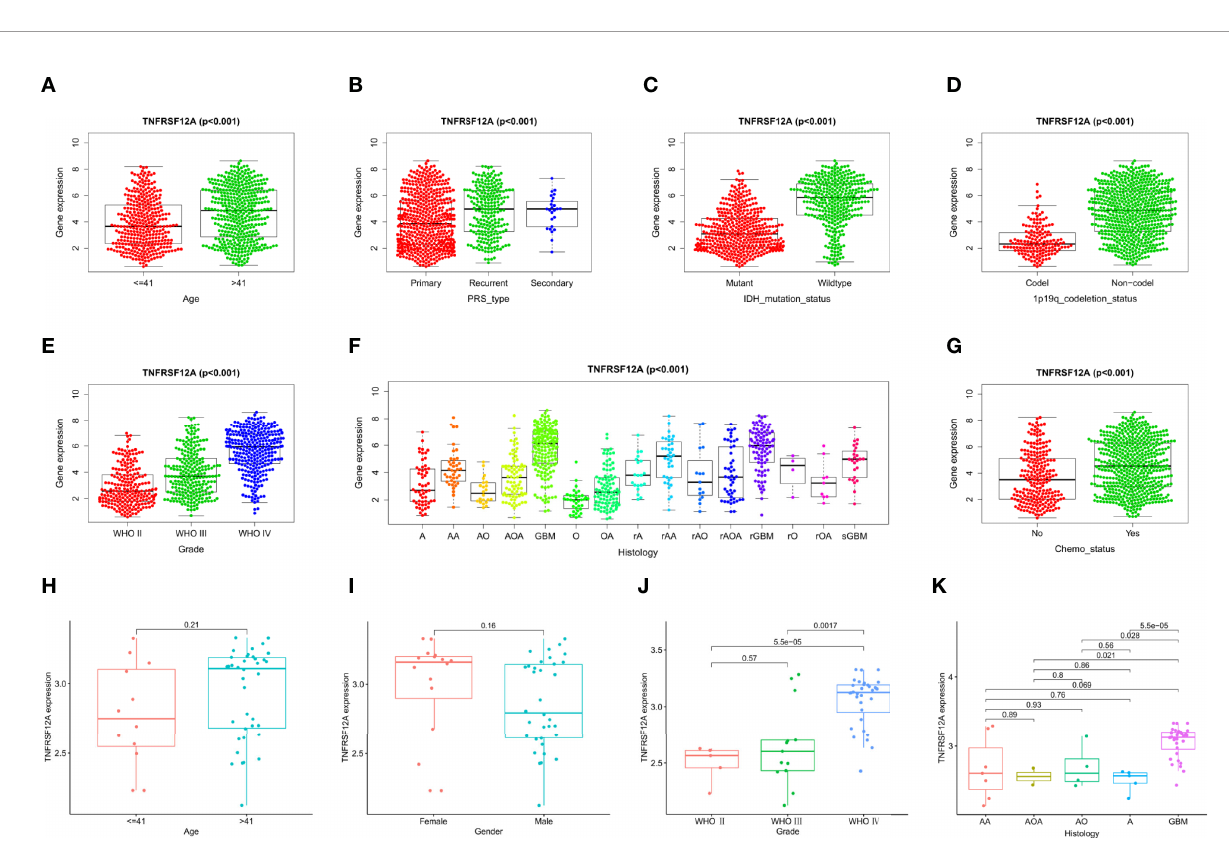
FIGURE 7 | Correlation analysis of TNFRSF12A expression levels and clinical features in glioma patients. CGGA: (A) Age. (B) PRS type. (C) IDH mutation. (D) 1p19q co-deletion. (E) Grade. (F) Histology. (G) Chemotherapy. GSE43378: (H) Age, (I) Gender, (J) Grade. (K)